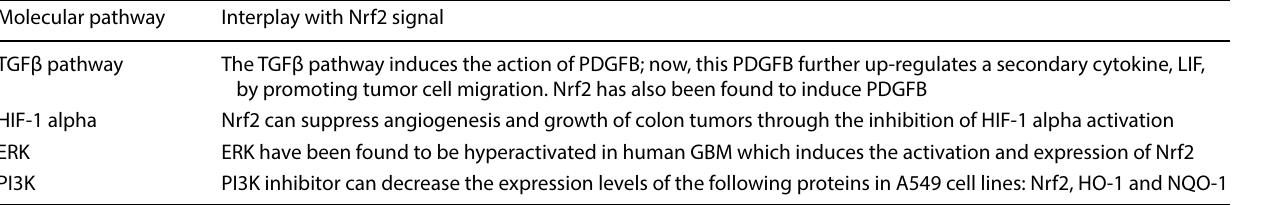
Table 1 A summary of the interactions between Nrf2 and other molecular signals implicated in GBM Molecular